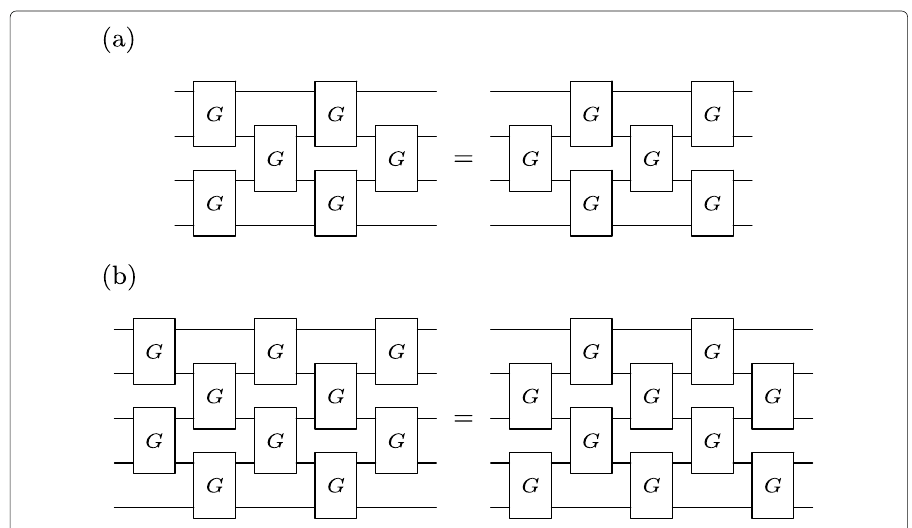
Fig. 1 Conjectured H CD matchgate mirroring identities for four qubits ( a ) and for five qubits ( b )